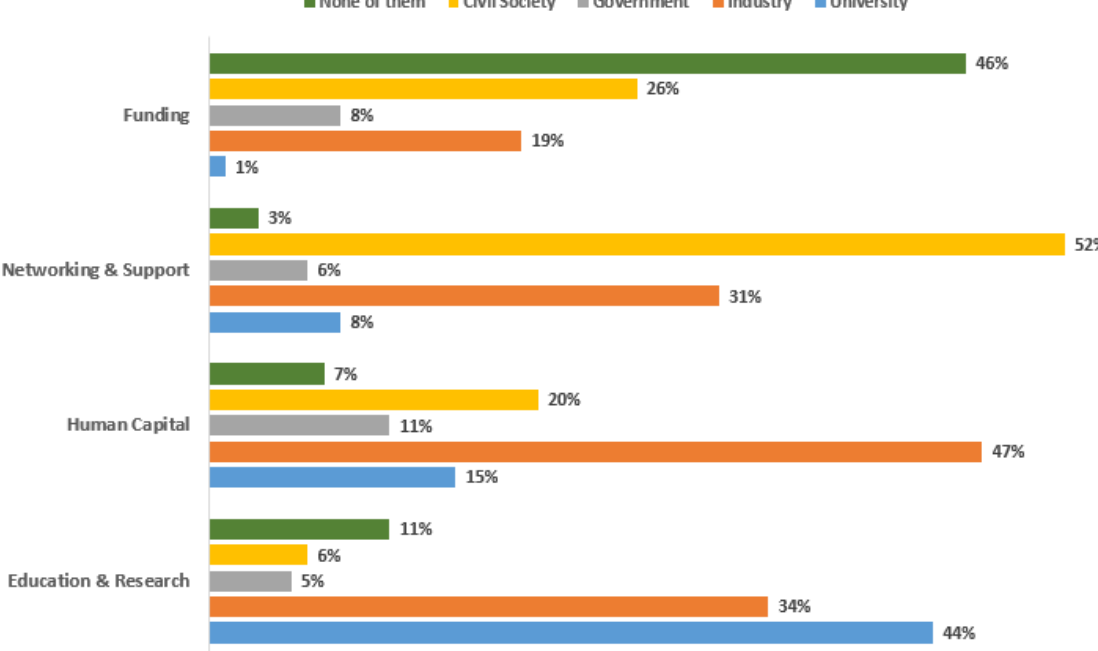
Figure 5. Stacked barplot describing start-up connections with ecosystem entities.